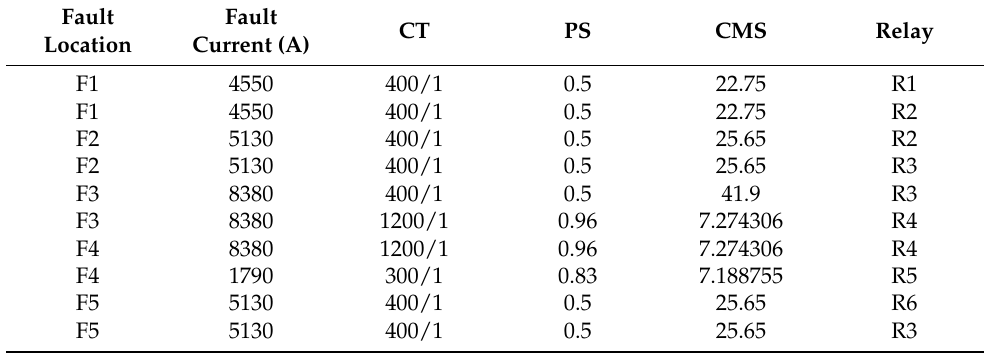
Table 4. The short-circuit currents values, PS, and CMS setting for IEC network without DG. Fault